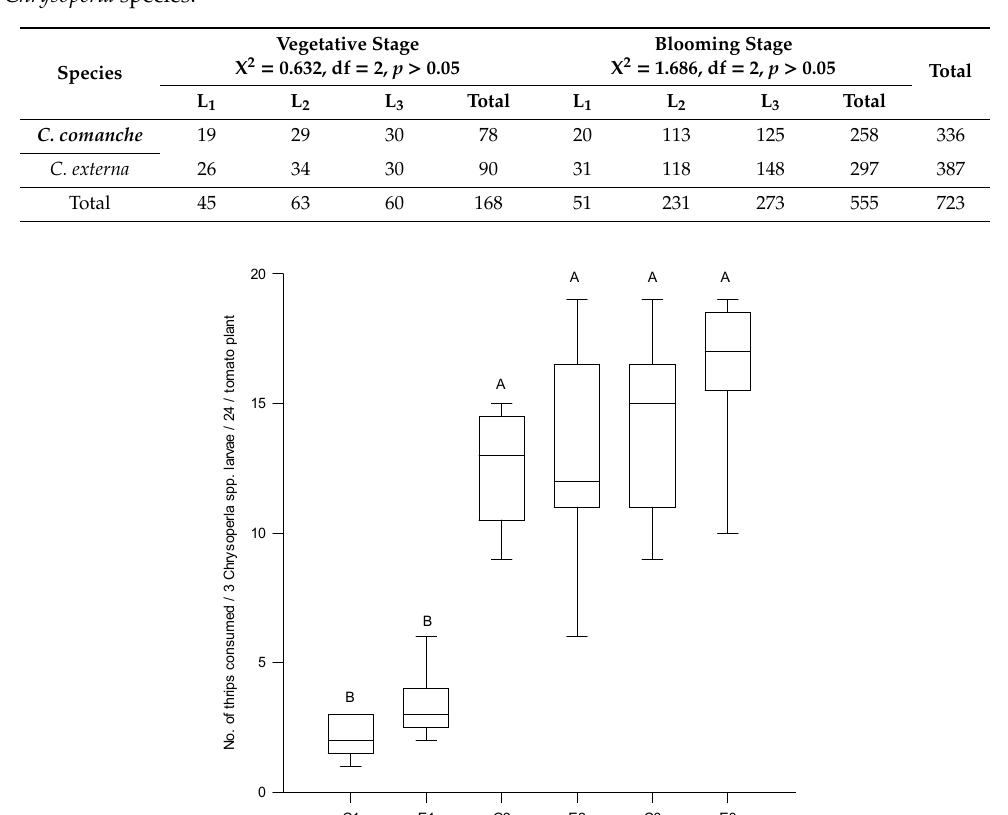
Table 1. Adults of Frankiniella occidentalis consumed in a 24 h period by first, second and third instar larvae of Chrysoperla comanche and Chrysoperla externa on tomato plants at vegetative and blooming stage under glasshouse conditions. Letters in bold are the sum of the adults thrips consumed by each Chrysoperla species.